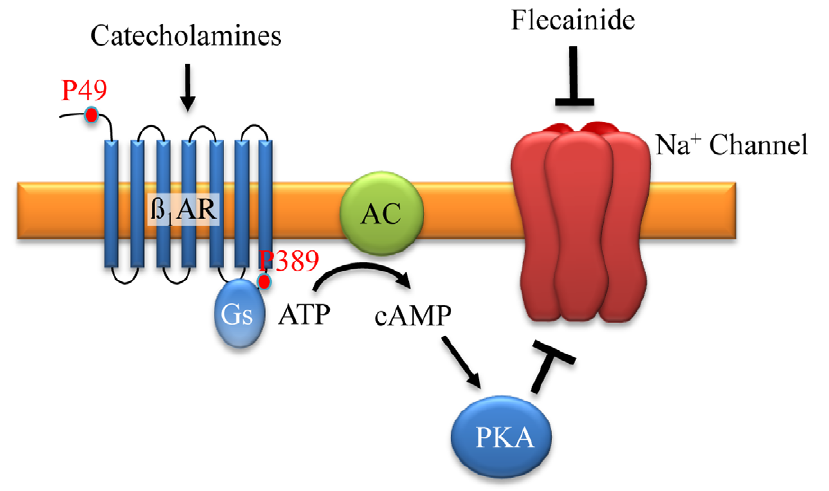
Figure 4. Schematic explanation of beta 1 -adrenoceptor and flecainide interaction. Localisation of P49 on N-terminus and P389 on C- terminus. b 1 AR activation results via G protein (Gs) and adenylate cyclase (AC) pathway in increase of cyclic adenosine monophosphate (cAMP) and activation of protein kinase A (PKA). PKA induced phosphorylation inactivates I Na channel activity. Flecainide inhibits I Na